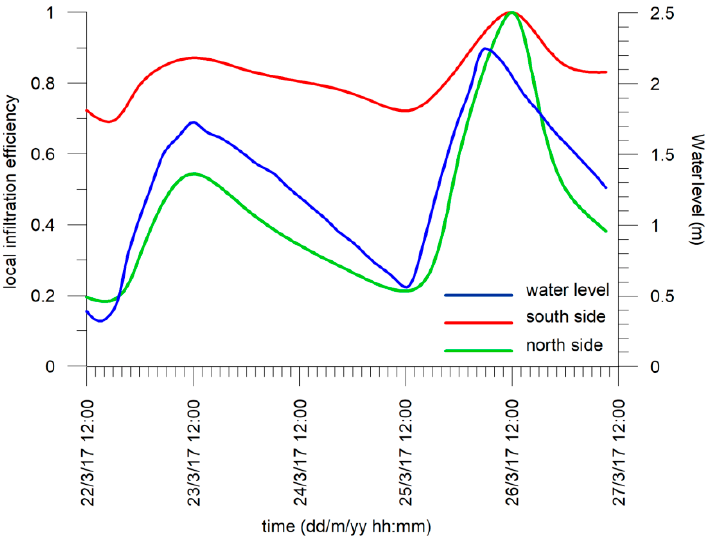
Figure 12. Local infiltration efficiency vs. time estimated in two points located in the north and south portions of the trench.